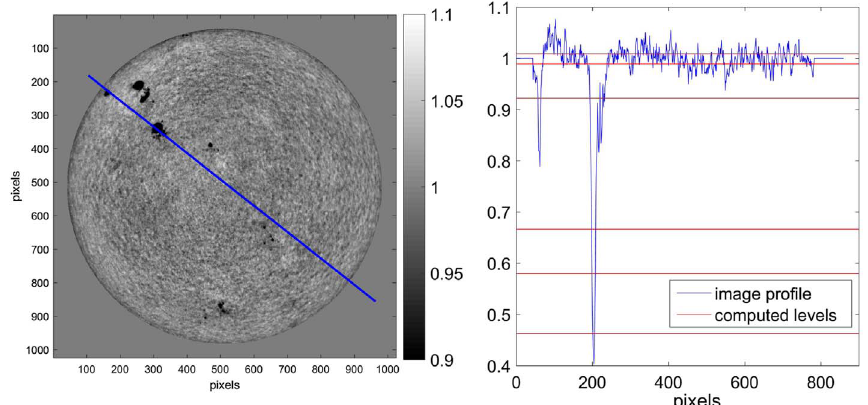
Fig. 7. Left panel : sample of a ratio intensity image ( I R r þ = CLV component of the K channel), the blue continuous line shows a transverse cut; right panel: the pro fi le (blue line) along the cut is reported in comparison with the six thresholds (red continuous lines) derived by the Otsu transform. The lowest threshold is the 1st while the highest is the 6th. The abscissa range of the plot is in pixels and corresponds to 900 pixels, i.e., the solar